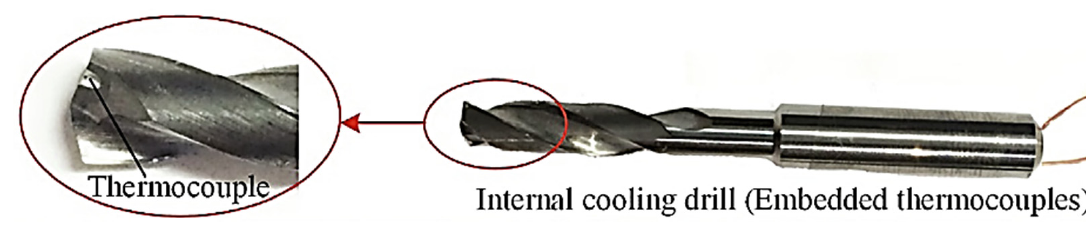
Figure 13. Thermocouples in the drill (adapted from [93]).